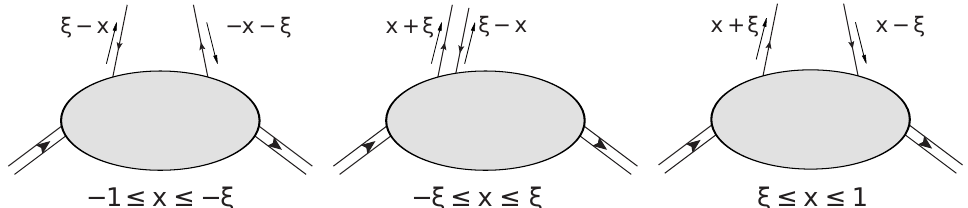
Figure 3. The DGLAP or ERBL regions and their different interpretations in terms of partons. From left to right, one goes through the antiquark interpretation of the probed parton. Then, in the inner ξ < x < ξ , one recovers the ERBL region and its interpretation as the “extraction” of a region − quark–antiquark pair from the hadron. Finally, on the right-hand side, ξ < x < 1 and we recover the quark interpretation of the DGLAP